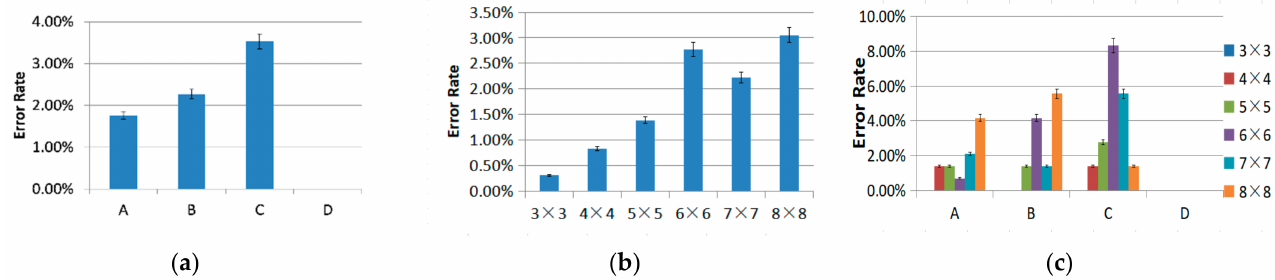
Figure 6. The error rate of Experiment 1. The error bars represent a 95% confidence interval: ( a ) average error rate with different regions; ( b ) average error rate with different target size levels; and ( c ) average error rate for different target size levels under different regions (A, B, C, and